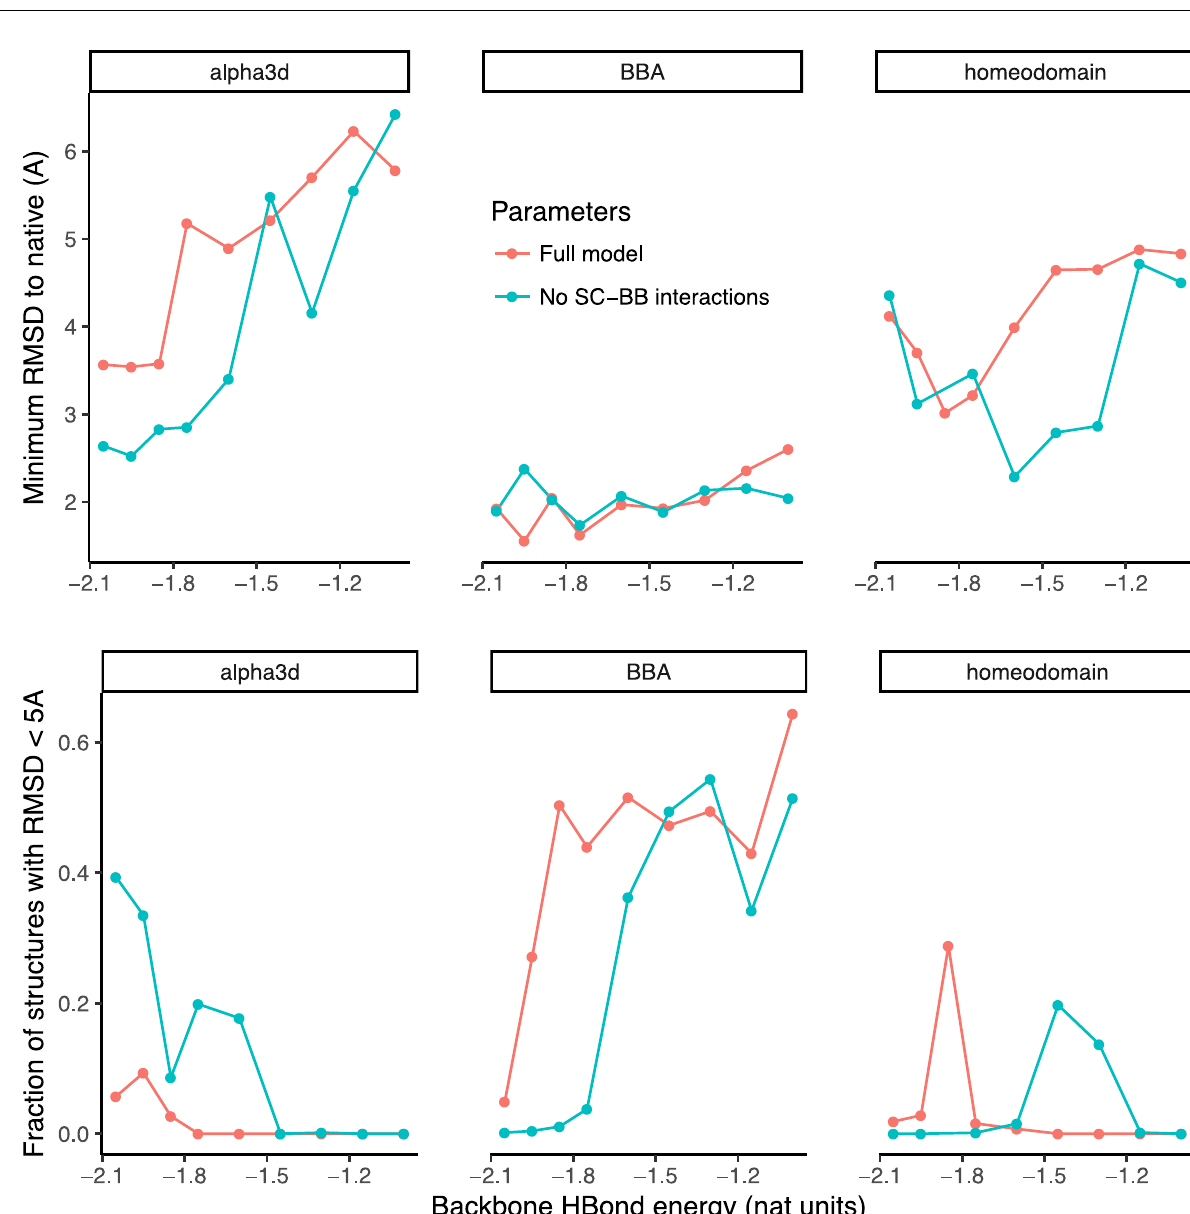
Fig 8. Accuracy of MD simulations for three proteins at variable backbone hydrogen bond strength. Results with and without side chain- backbone interactions are presented.